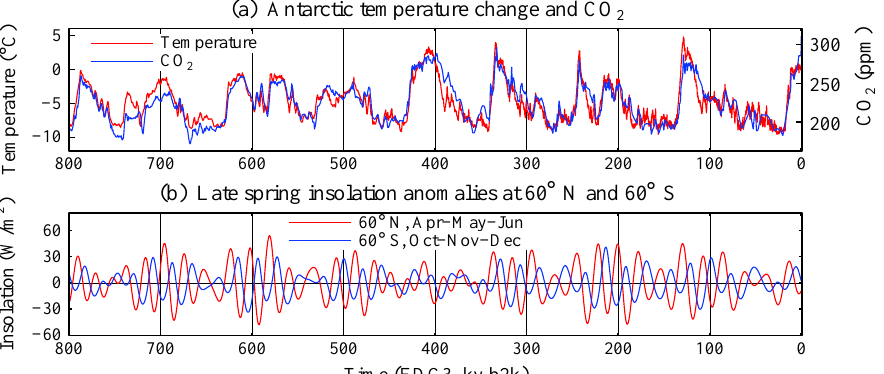
Figure 28. (a) Antarctic (Dome C) temperature relative to last 10ky (Jouzel et al., 2007) on AICC2012 timescale and CO 2 amount (Luthi et al., 2008). Temperature scale is such that standard deviation of T and CO 2 are equal, yielding (cid:49)T ( ◦ C) = 0.114 (cid:49) CO 2 (ppm). (b) Late spring insolation anomalies at 60 ◦ N and 60 ◦